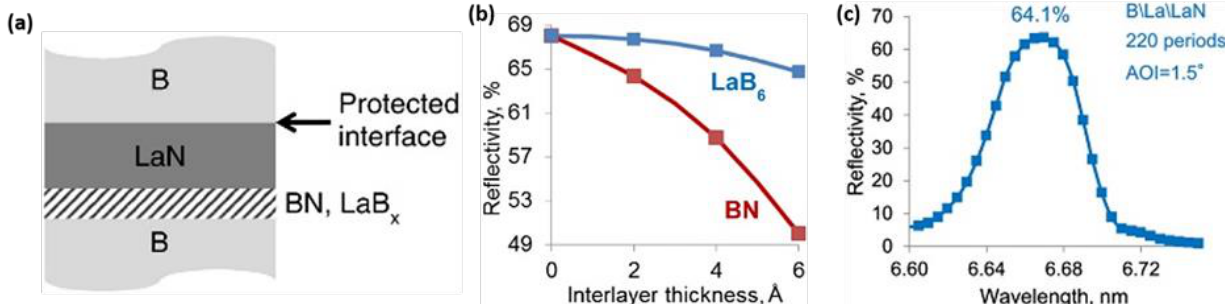
Figure 9. ( a ) Simplified drawing of a La/B multilayer with nitridated lanthanum. The B-on-LaN interface is secured from chemical interaction, whereas BN and LaB x can develop at the LaN-on-B interface. ( b ) Modeled peak reflectivity of the LaN/B multilayers with BN and LaB 6 as interlayers on the LaN-on-B interface. λ = 6.65 nm, AOI at 1.5 ◦ off-normal incidence. ( c ) Measured optical reflectivity of a 220 period B \ La \ LaN PMM with La interlayers of 0.3 nm thickness introduced at the LaN-on-B interface. The measurement was undertaken at 1.5 ◦ off-normal AOI. Reprinted with permission from [10] © The Optical Society.